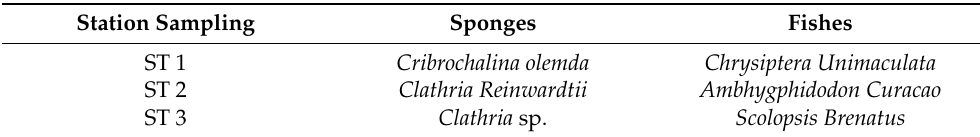
Table 2. Fish and sponge morphology based on the sampling